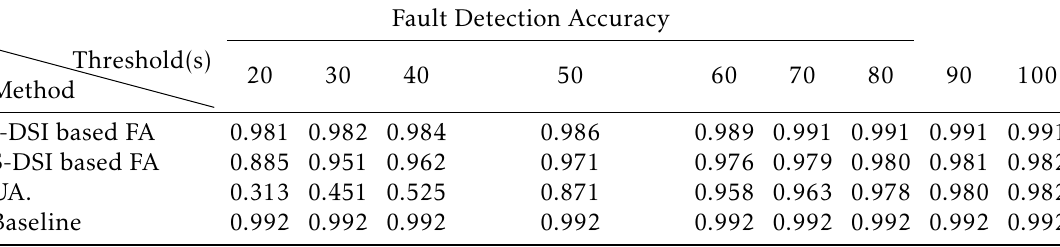
Table 8. Effect of latency limit as well as overall interaction data transfer on the FA schemes along with